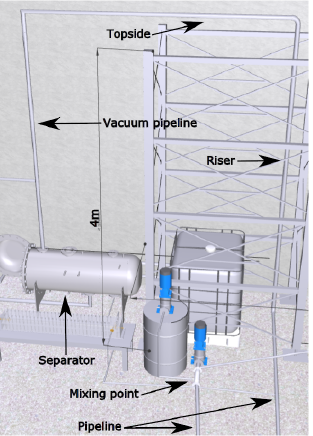
Figure 1. An illustrative 3D drawing of the test rig at Aalborg University Esbjerg. The figure shows the mixing point between liquid and gas to a horizontal pipeline joint with a riser and a vacuum pipeline down to a 3-phase separator at ground level. The illustration does not include the choke valves since they can be moved along all pipeline and riser